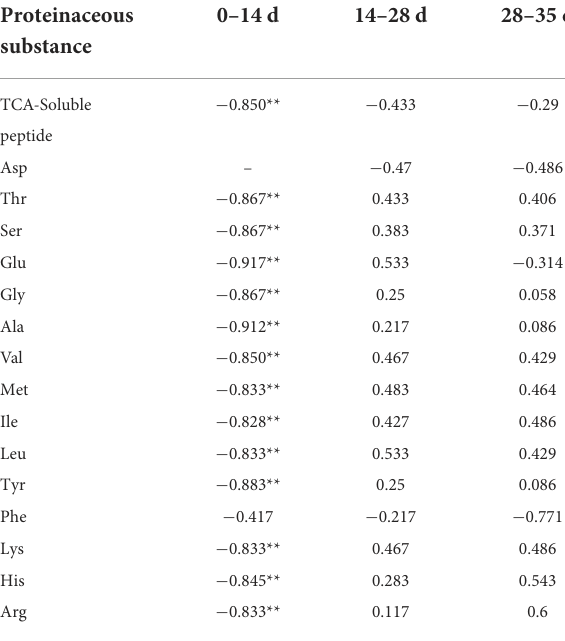
TABLE 4 Spearman correlation analysis between endogenous protease activity and proteinaceous substance in preserved egg